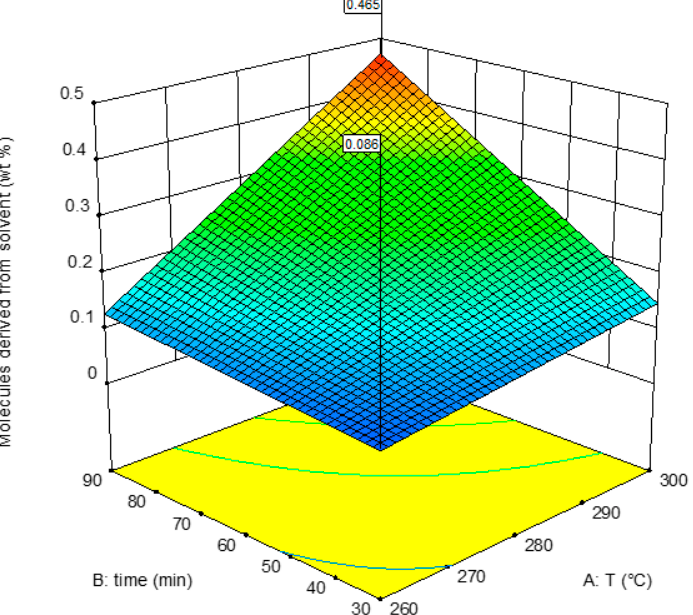
Figure 9. Prediction of the production of the molecules derived from the solvent at different condi- tions of temperature and residence time.